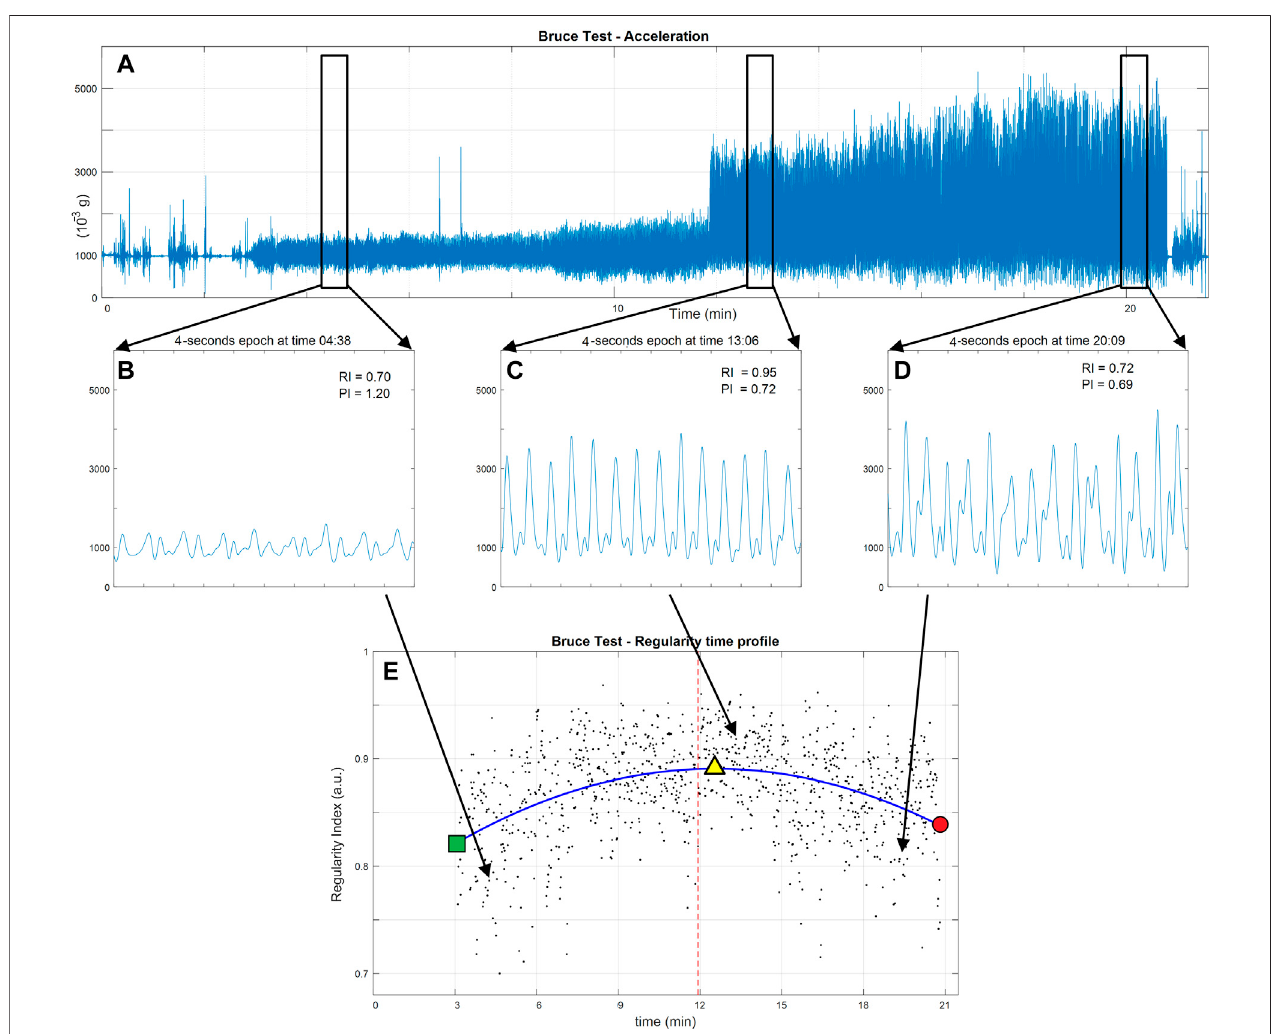
FIGURE 1 | Data fl ow in the analysis of regularity of a Bruce test performance in a representative subject. (A) The norm of the acceleration as measured by a wrist triaxialaccelerometer. (B – D) Zoom-inontheaccelerationpatterninthreerepresentative4-sepochs[ (B) initialslowwalking, (C) runningfollowingthewalk – runtransition, and (D) running at high-speed just before the test ends due to physical exhaustion). In the upper right-hand corner of each plot, the epoch ’ s regularity index (RI) is presentedalongwiththedurationofthelocomotorcycle(PI).Thelowerpanel (E) showsthescatterplotofallregularityindicescomputedforallepochs(blackdots). The time pattern of regularity (blue line) is identi fi ed as the fi tted second-order polynomial. The walk-to-run transition is presented as a red vertical line. The start of locomotiontestismarkedontheregularitypatternbythegreensquareanditsendbythereddot.Thepeakofregularityismarkedbytheyellowtriangle.Time(inminutes) is in accordance with the Bruce test